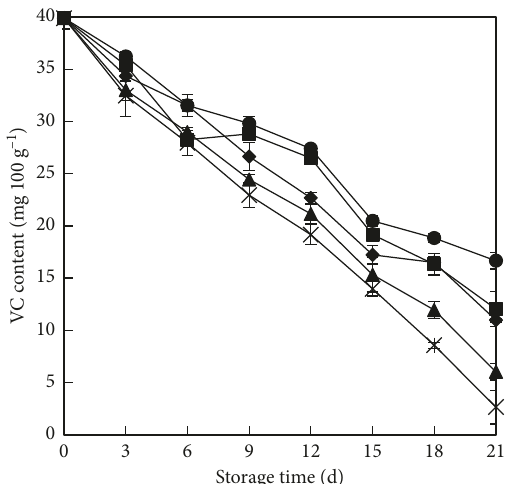
Figure 2: Effects of 1-MCP on Vc content of yardlong bean fruit during storage at 8 ° C. Error bars represent standard error of the means. Control ( ✲ ), 0.75 μ L · L − 1 ( ■ ), 1.0 μ L · L − 1 ( • ), 1.25 μ L · L − 1 ( ◆ ), and 1.5 μ L · L − 1 ( ▲ ).